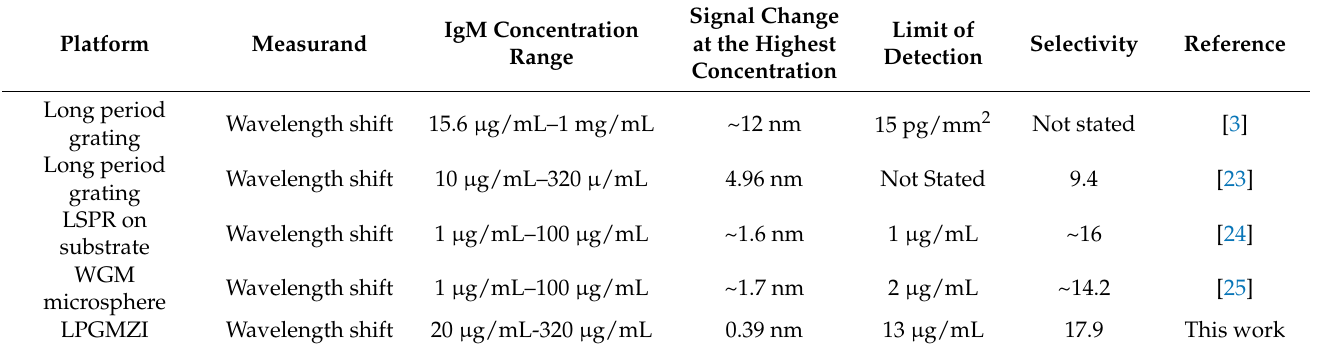
Table 1. The characteristics of different optical IgM